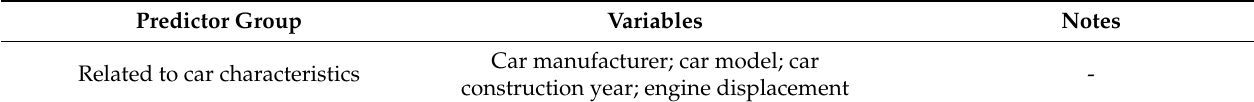
Table 2. Fuel consumption predictors and their